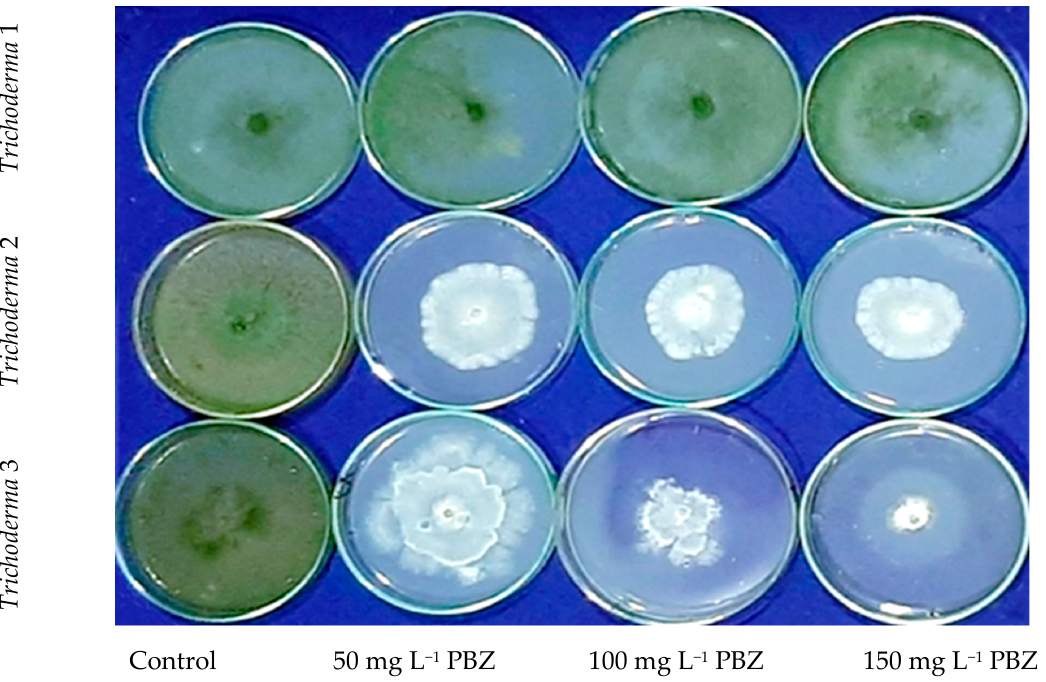
Figure 4. Antifungal effects of PBZ at three concentrations on three isolates of Trichoderma spp. Table 4. The impacts of PBZ concentrations on mycelial growth and inhibition (%) of the three Trichoderma isolates on PDA